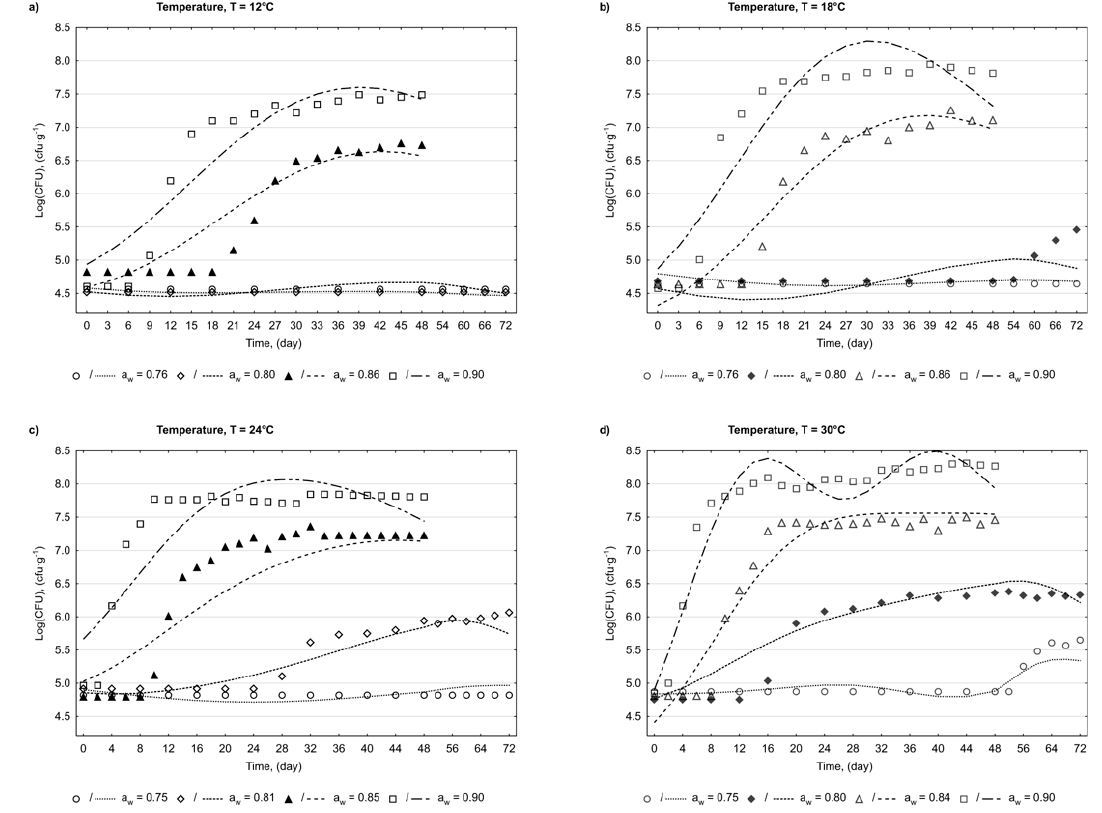
Figure 6. The comparison of RBF neural network model predictions (model lines) and observed mold population levels (log(CFU)) (experimental points) in rapeseed ecosystems with water activity a w = 0.75–0.90 stored at: ( a ) 12 ◦ C, ( b ) 18 ◦ C, ( c ) 24 ◦ C, ( d ) 30 ◦ C adopted from Wawrzyniak et al. [6] as a function of time (empty points – data used to model construction, filled points – validation data